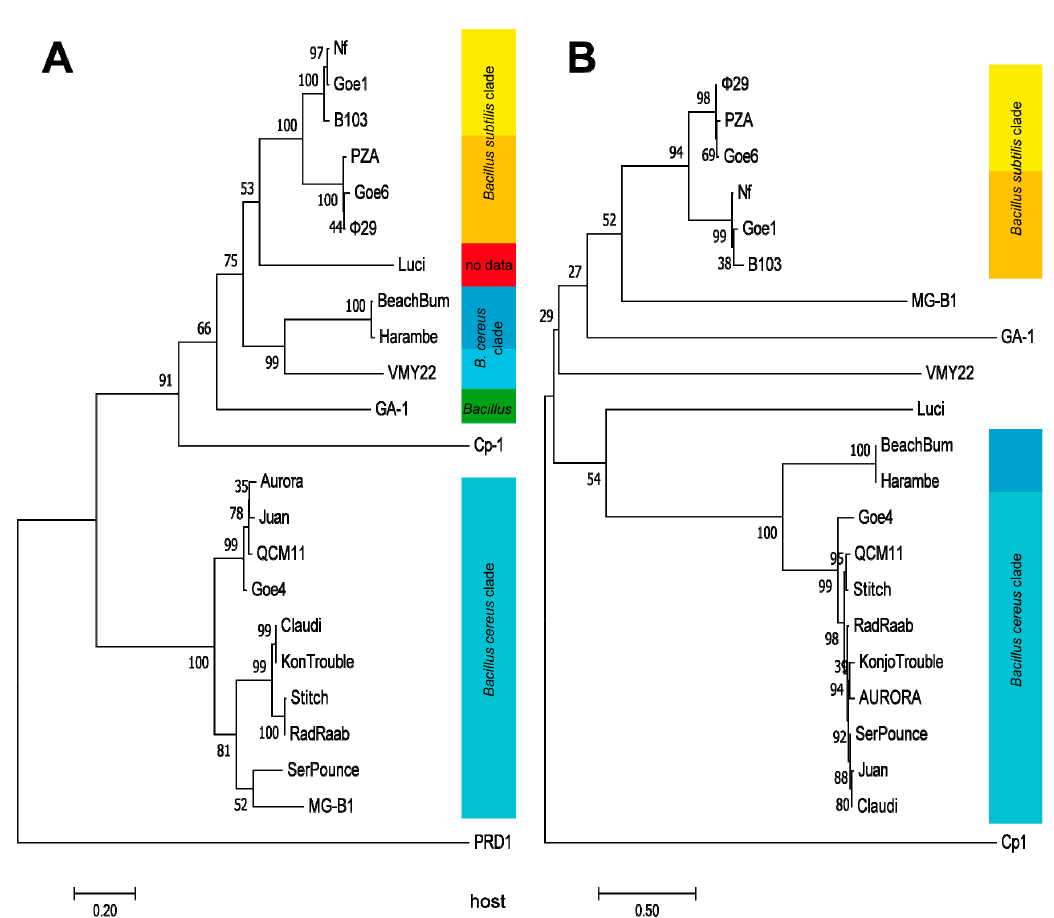
Figure 5. Molecular Phylogenetic analysis, using the Maximum Likelihood method. The evolutionary history was inferred by using the Maximum Likelihood method based on the JTT matrix-based model [39]. Trees with the highest log likelihood ( − 13,127.87 for ( A ) and − 17,734.54 for ( B )) are shown. The percentage of trees in which the associated taxa clustered together are shown next to the branches. Initial tree(s) for the heuristic search were obtained automatically by applying Neighbor-Join and BioNJ algorithms to a matrix of pairwise distances estimated using a JTT model, and then selecting the topology with superior log likelihood value. The trees are drawn to scale, with branch lengths measured in the number of substitutions per site. DNA-polymerase served as marker protein for tree ( A ) and the pre-neck-appendage protein for ( B ). The analysis involved 23 amino acid sequences with a total of 735 positions in the final dataset for ( A ) and 22 amino acid sequences with a total of 1015 positions for ( B ). The respective hosts are listed on the right side of each dendrogram and colour coded like in Figure 4.